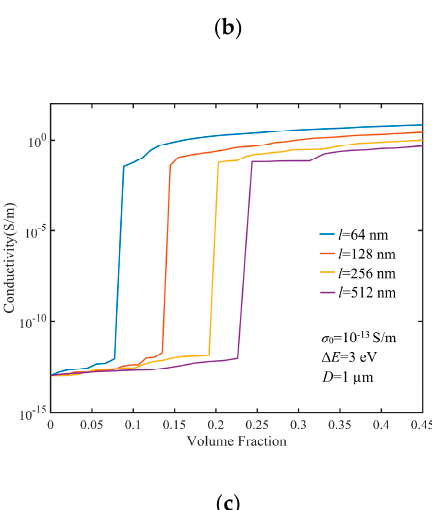
Figure 8. Electrical conductivity of GNP composites with different GNP thicknesses: ( a ) l = 0.344, 0.69, 1, and 2 nm; ( b ) l = 4, 8, 16, and 32 nm; and ( c ) l = 64, 128, 256, and 512 nm.